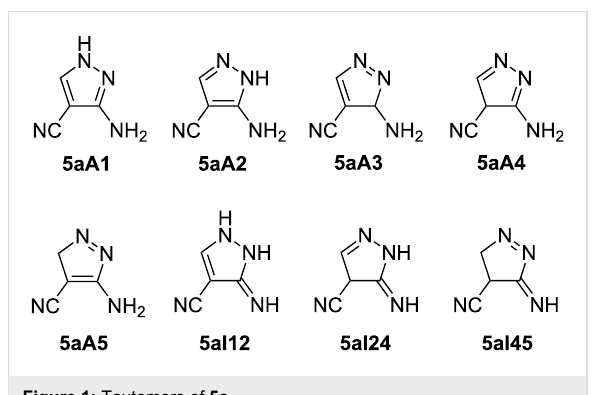
Figure 1: Tautomers of 5a .